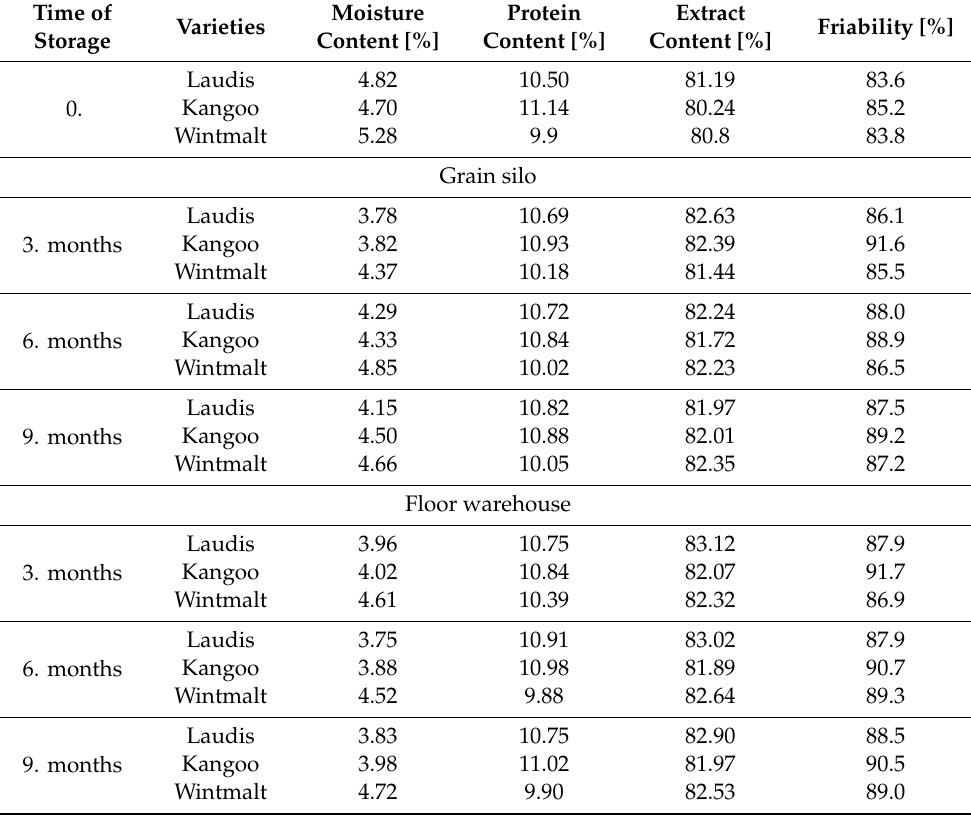
Table 5. Malt basic chemical parameters.